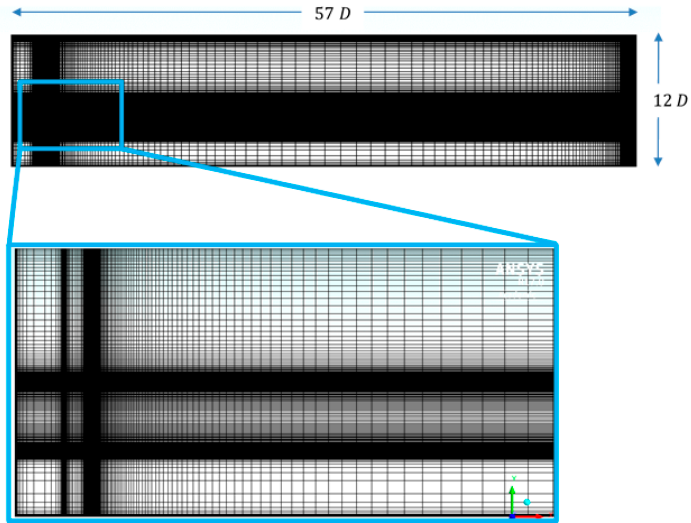
Figure 2. Mesh used in the numerical analysis for 90-degree jet angle with close-up mesh image showing fine mesh near the wall.